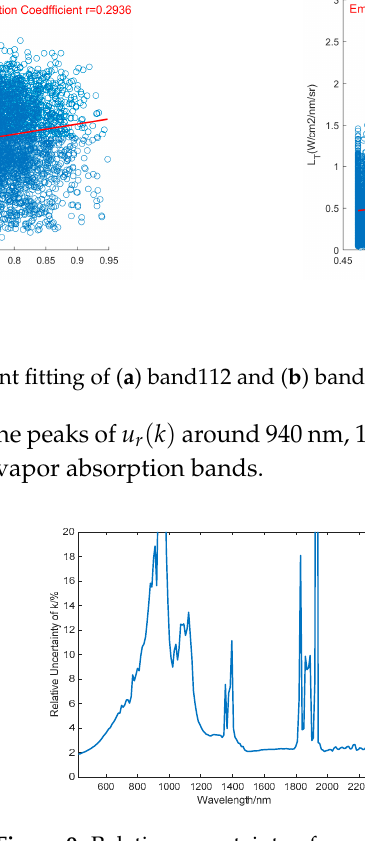
Figure 9. Relative uncertainty of parameter k .